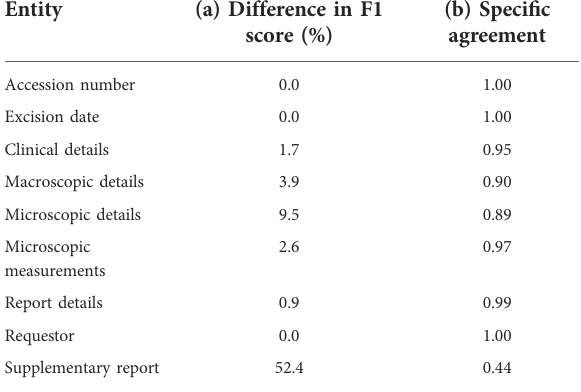
TABLE 4 Differences in (a) F1 score between annotators on the validation corpus and (b) inter-annotator agreement on the validation